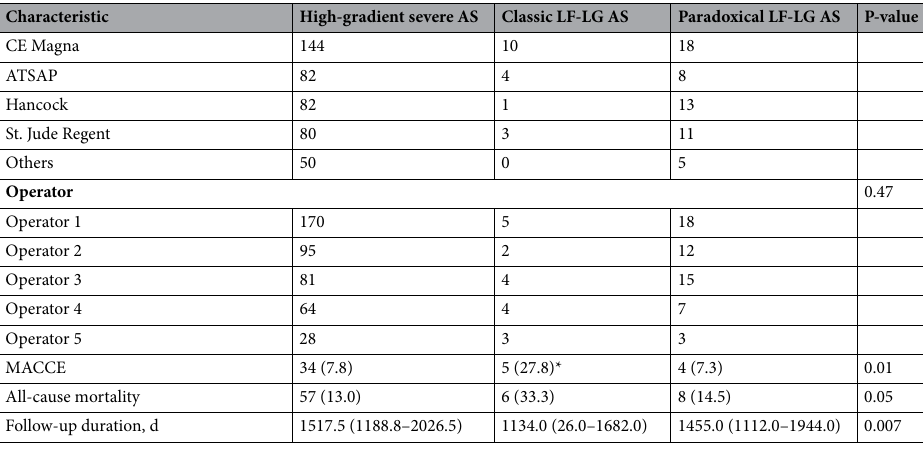
Table 1. Clinical and imaging characteristics of high-gradient severe, classic LF-LG, paradoxical LF-LG AS groups (n = 511). Values are means ± standard deviations or numbers and percentages in parentheses. *Significant difference between patients with high-gradient severe aortic stenosis and patients with classic LF-LG AS groups. † Significant difference between high-gradient severe aortic stenosis and paradoxical LF-LG AS groups. ‡ Value divided by sex-specific thresholds (Male, 2000; Female, 1250). AS aortic stenosis, AV aortic valve, AVA aortic valve area, AVC aortic valve calcium score, BNP B-type natriuretic peptide, CABG coronary artery bypass graft, EDVI end-diastolic volume index, ESVI end-systolic volume index, LF-LG low-flow and low-gradient, lnBNP log-transformed B-type natriuretic peptide, LVEF left ventricular ejection fraction, LVMI left ventricular mass index, LVOT left ventricular outflow tract, MACCE major adverse cardiac and cerebrovascular event, N/A not available, PCI percutaneous coronary artery intervention, PG pressure gradient, SAC systemic arterial compliance, VTI velocity time integral, Zva valvulo-arterial impedance.